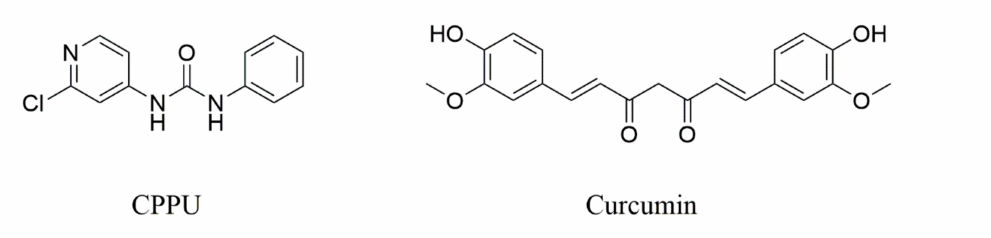
Figure 4. Structural formulas of 1-(2-chloro-4-pyridyl)-3-phenylurea (CPPU, forchlorfenuron), and